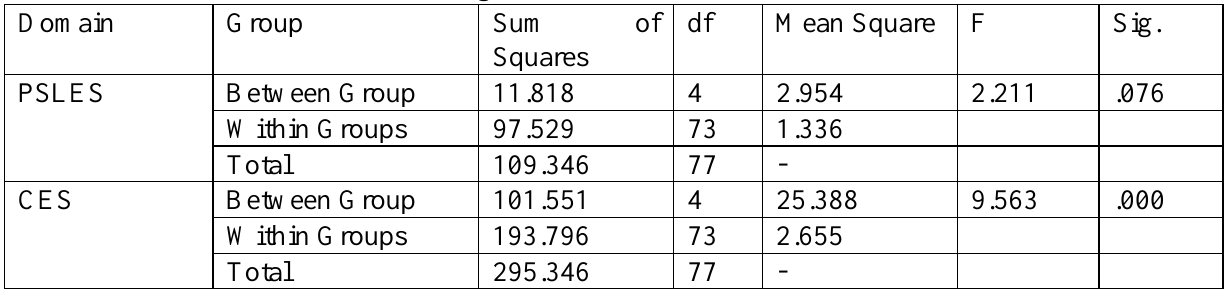
Table 6. Comparison of Scores on different measures of Presumptive Stressful Life Event